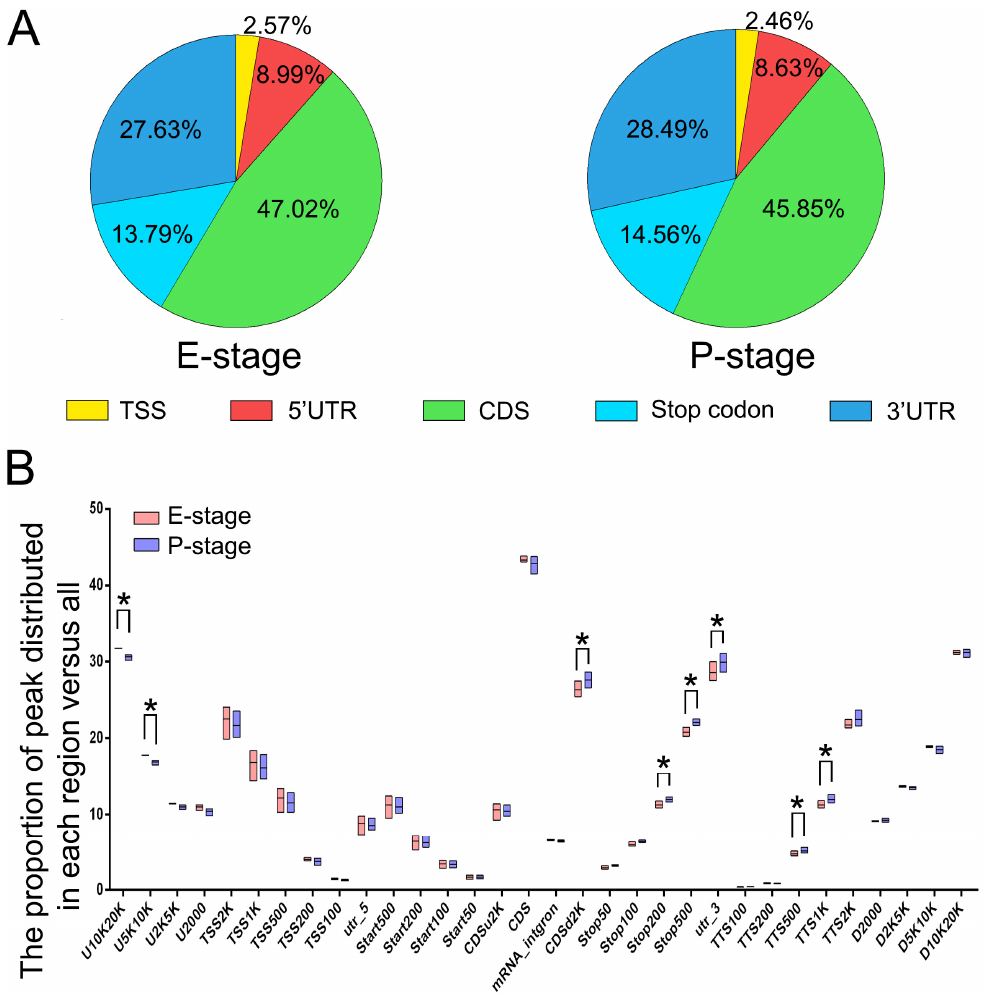
Figure 3. Patterns of m 6 A-methylation within transcribed RNAs. ( A ) The proportion of m 6 A peaks distributed among five cortical RNA regions at E- or P-stage. ( B ) The proportion of m 6 A peaks distributed in the genome. U: upstream; D: downstream; TSS: translational start site; TTS: translational termination site; UTR: untranslated region; start: translation start codon; stop: translation stop codon; CDS: coding sequence; K: kilobase. The U2000 and D2000 refer to 2000 bp upstream of genes and 2000 bp downstream of genes, respectively. CDSu2k and CDSd2k refer to 2KB upstream and downstream